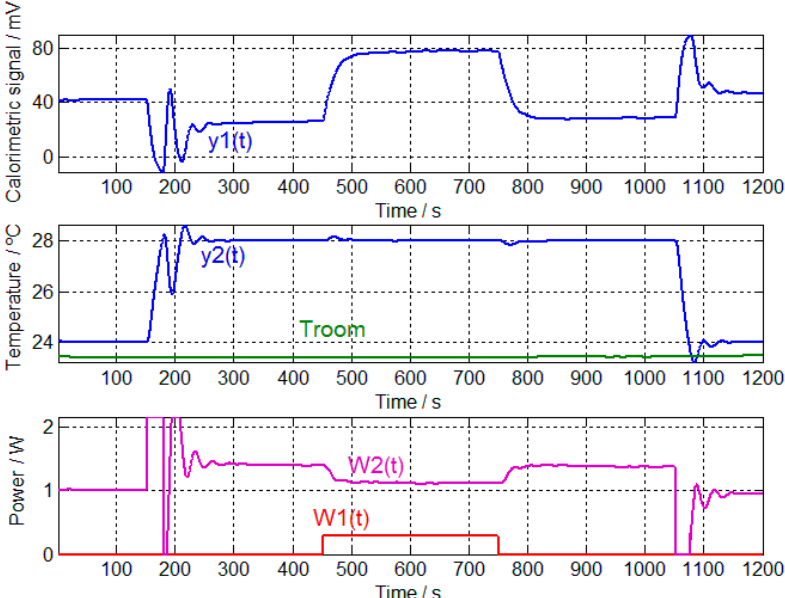
Figure 2. Calibration measurements, including calorimetric signal y 1 ( t ), thermostat temperature y 2 ( t ), room temperature T room , power dissipated in the resistor placed on the calibration base W 1 ( t ) and power dissipated in the thermostat W 2 ( t ).